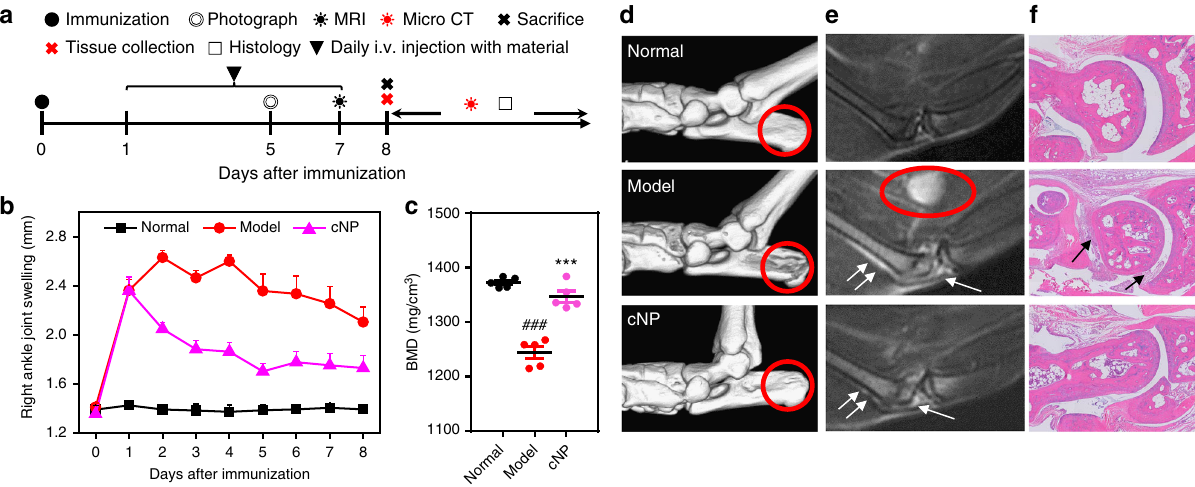
Fig. 3 cNP improves the arthritic condition of BALB/c mice induced by CpG. a Experimental schedule of the mice study. Acute arthritis developed one day after articular injection with CpG. Then arthritis mice were injected i.v. daily with 12.5 mg/kg cNP from day 1 to day 7. Further study was performed after sacri fi cing mice at day 8. b Right ankle joint swelling of all mice was evaluated daily by measuring the diameter of the right ankle with a digital caliper ( n = 5). c Analysis of BMD of mice ankle joint from Micro-CT data. Statistical signi fi cance was calculated by one-way ANOVA with the LSD post-test, *** P < 0.001 versus model group, ### P < 0.001 versus normal group. d Representative micro-CT images of the ankle joint of BALB/c arthritis mice after administration for 7 days with a resolution of 19 μ m. 3D images were reconstructed using Inveon Research Workplace. Various levels of bone destruction in calcaneus are shown in red circles. e Representative T2-weighted MRI images of ankle joint of mice at day 7. The swollen popliteal lymph node (red circle), effusion in the joint (single arrow), and suprapatellar bursa (double arrow) appeared in the model, while treatment with cNP ef fi ciently prevented these pathological changes. f Representative HE staining of ankle joints of mice after administration for 7 days (×200). Some in fl ammatory cell in fi ltration (single arrow) appeared in the articular cavity of model. In b and c data were presented as the mean ± decreased from 2.4 mm before injection to 1.7 mm at the end of 7 days. The micro-CT images show that the bone mineral density (BMD), a marker of bone loss, of the cNP-treated group (Fig. 3c) recovered from 1243 to 1346 mg/cm 3 , a level close to the normal mice. Bone destruction, as highlighted in the circled region in Fig. 3d, was undetectable after treatment. Percent bone volume and trabecular thickness also returned to those of the normal group (Supplementary Fig. 7b). The other parameters, such as bone surface area/bone volume, trabecular spacing and trabecular pattern factor, were decreased to the levels close to the normal control.